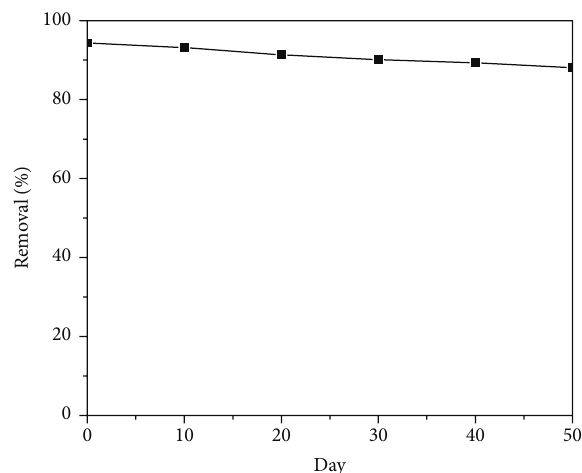
Figure 9: Long-term stability of modified red mud. Experimental conditions: 5 × 10 −5 mol/L MO, 0.7 g/L modified red mud, and irradiation time of